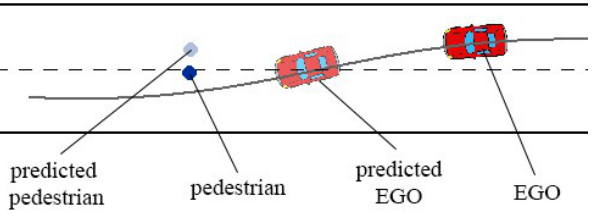
Figure 5. Top-view visualization.